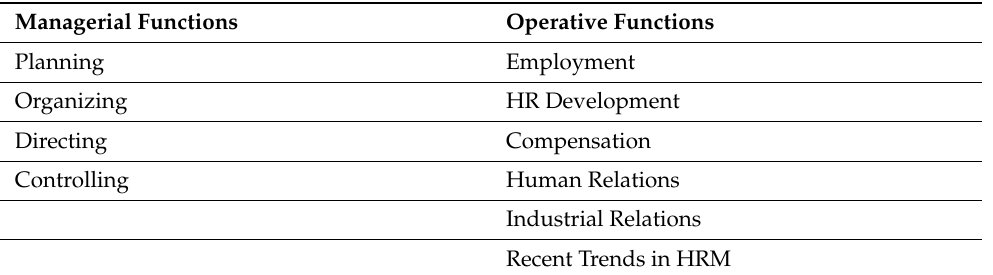
Table 3. The functions of